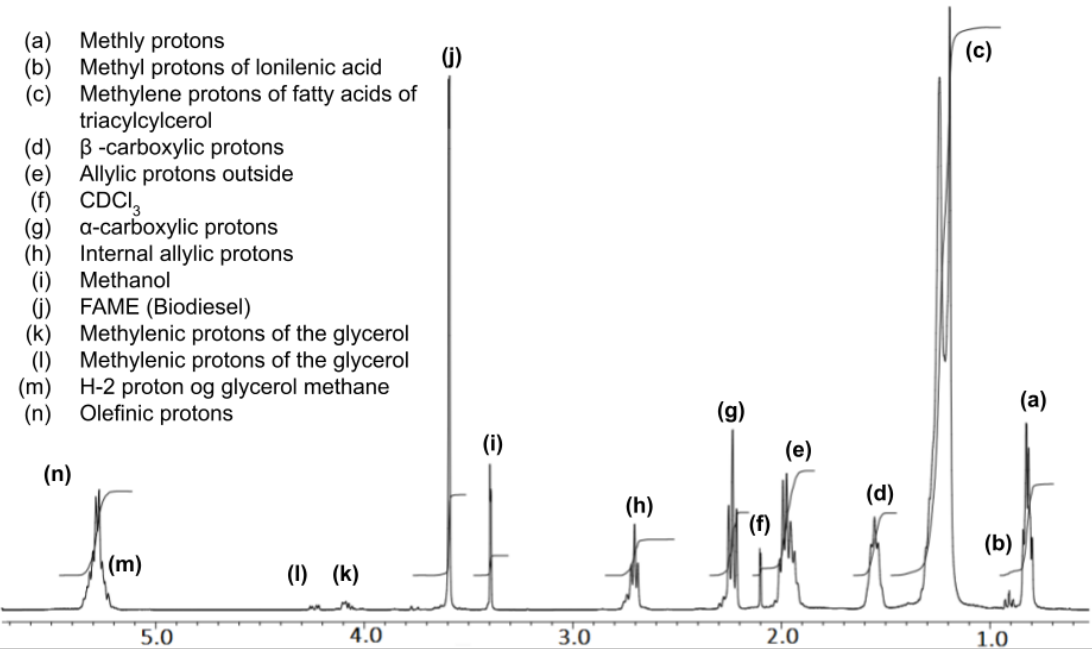
Figure 17. 1 H-NMR spectrum of phase-separated biodiesel in CDCl 3